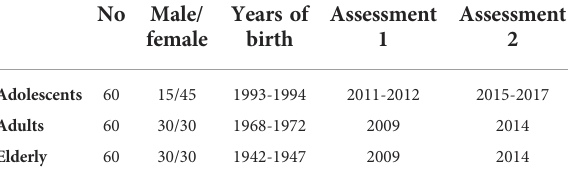
TABLE 1 Description of study population and